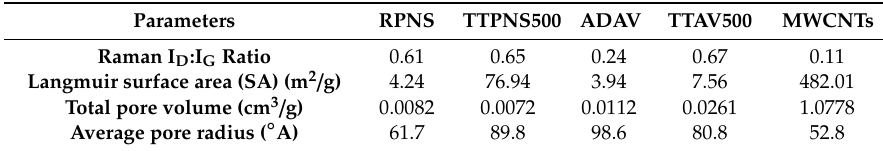
Table 6. Raman and Brunauer-Emmett-Teller (BET) analyses of RPNS, TTPNS500, ADAV, TTAV500 and thermally treated RPAL.